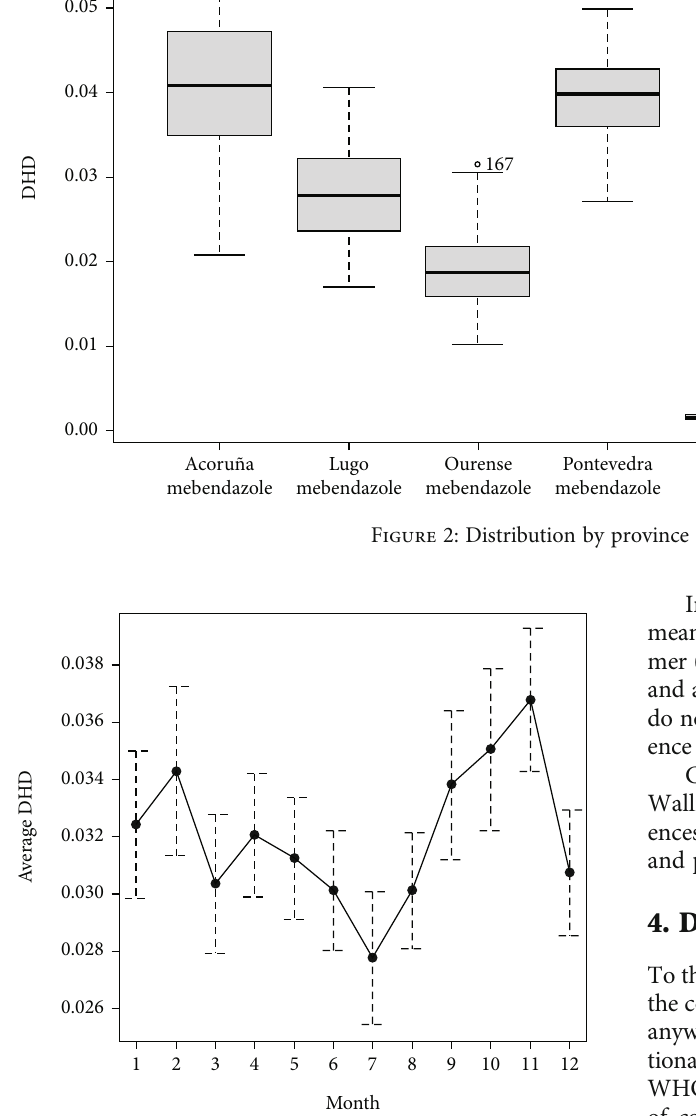
Figure 3: Mean and seasonal variability of DHD mebendazole.